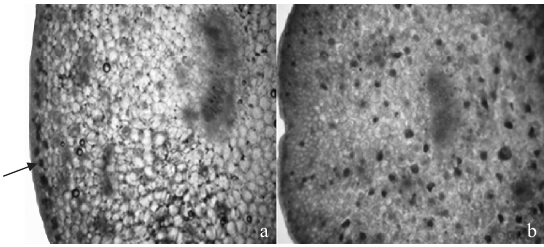
Fig. 6 - Anatomical cross sections in the middle portions of petioles of Kalanchoe brasiliensis (a) and Kalanchoe pinnata (b) grown under full sunlight. Arrow: Deposition of anthocyanins near the subjacent tissue to the petiole epidermis in Kalanchoe brasiliensis . Bars = 0.1mm. Leaf blades